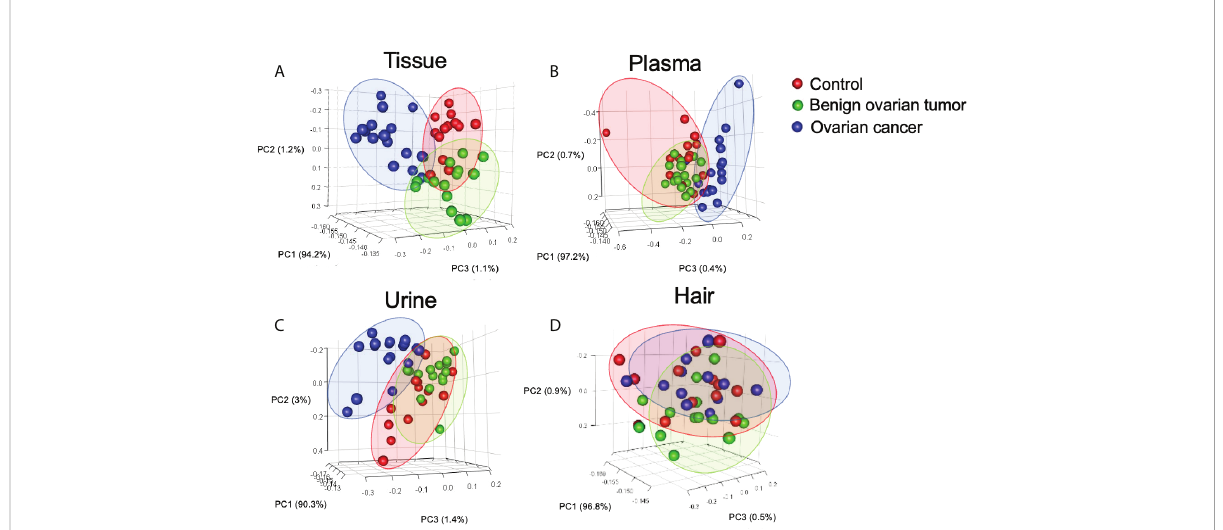
FIGURE 1 Principal component analysis (PCA) of identi fi ed metabolites in tissue (A) , urine (B) , plasma (C) , and hair (D) samples. Each point in the plot represents a patient. Red dots represent the control group, and green dots indicate the benign ovarian tumor group, blue dots represent samples derived from the ovarian cancer group. Number of tissue sample in control group (n = 14), BOT group (n = 16), and OC group (n = 16). Number of plasma sample in control group (n = 13), BOT group (n = 16), and OC group (n = 17). Number of urine sample in control group (n = 13), BOT group (n = 15), and OC group (n = 17). Number of hair sample in control group (n = 13), BOT group (n = 16), and OC group (n =